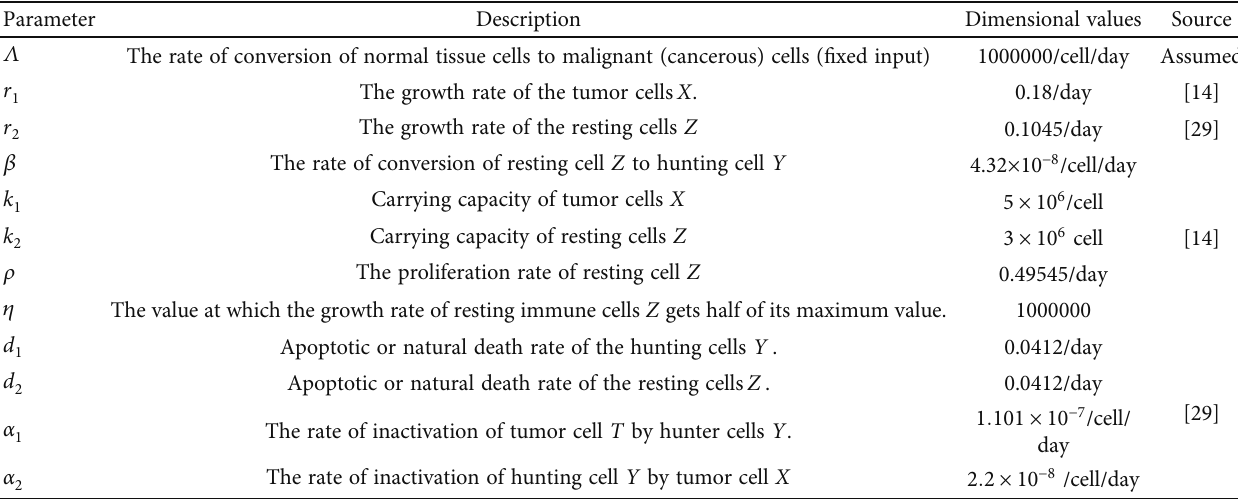
Table 1: Parameters of the model and their